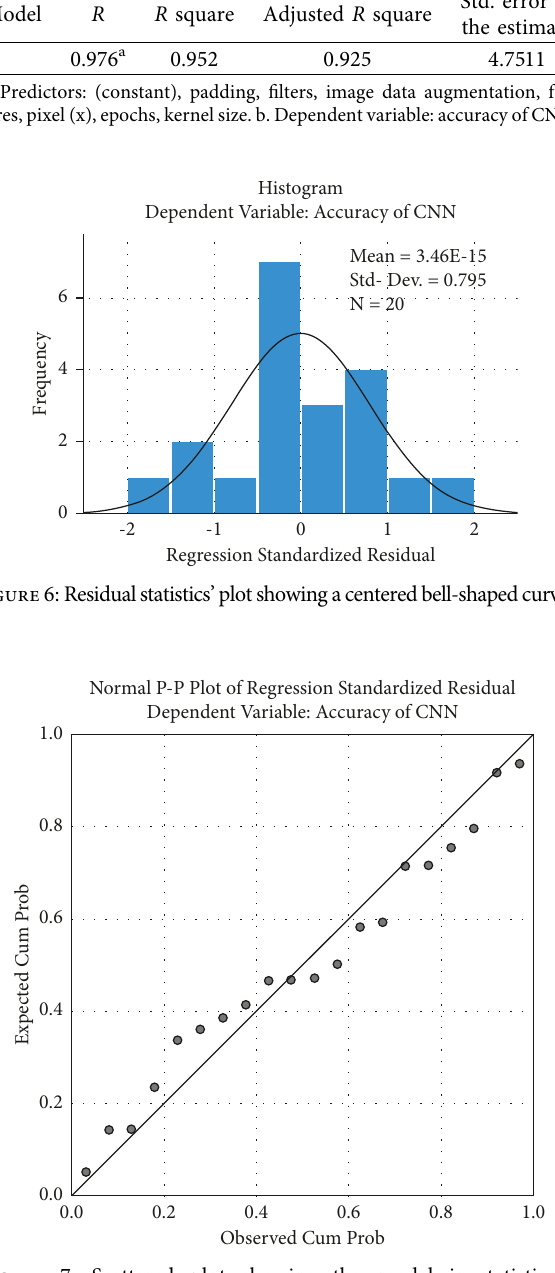
Figure 7: Scattered plot showing the model is statistically